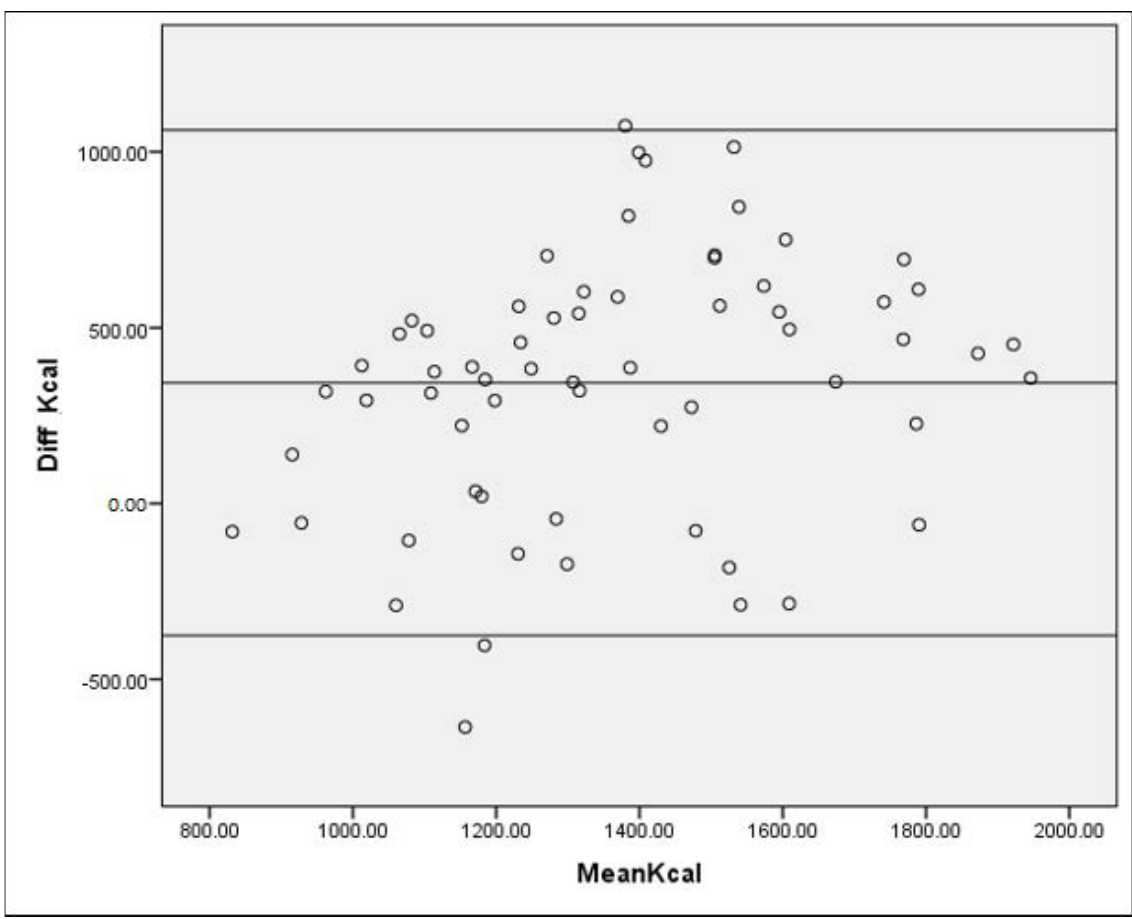
Figure 2. Bland–Altman plot of total energy intake. Differences in the daily intake of total energy estimated with 24-h dietary recalls and a FFQ plotted against the mean daily intake estimated by the two methods (n = 64). Mean difference and 95% limits of agreement (1.96 SD of mean difference) are included.